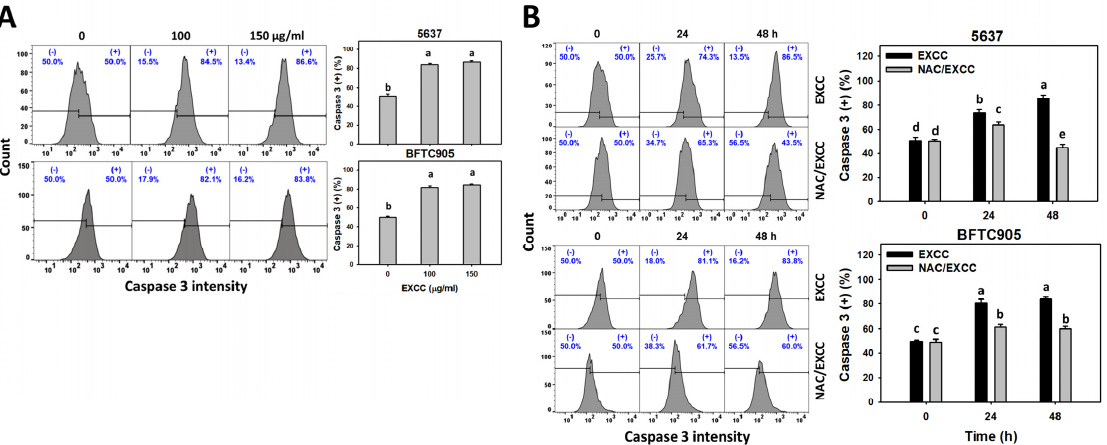
Figure 3. Apoptosis (annexin V) change by EXCC. ( A ) Annexin V assay of EXCC. Two bladder cancer cell lines (5637 and BFTC905) were tested. Cells were treated with control (0.1% DMSO) and EXCC (100 and 150 μ g/mL) for 48 h. Apoptosis (%) was determined by calculation of annexin V (+)/7ADD (±) (%). ( B ) Annexin V assay of NAC/EXCC. NAC/EXCC was NAC pretreatment (10 mM, 1 h) coupled with EXCC posttreatment (100 and 150 μ g/mL, 24 and 48 h). Statistical lower-case letters were given to each treatment. Non-overlapping letters between different treatments indicate significant results ( p < 0.05). Data, means ± SD ( n = 3). For example (5637 cells in Figure 3B), the EXCC (black color) 0, 24, and 48 h indicating “cd, b and a” show significant results between each other because these letters were not overlapping. In contrast, EXCC 0 (black color) and NAC/EXCC (gray color) 0 h indicating “cd and de” show nonsignificant results because these letters were overlapping with “d”.